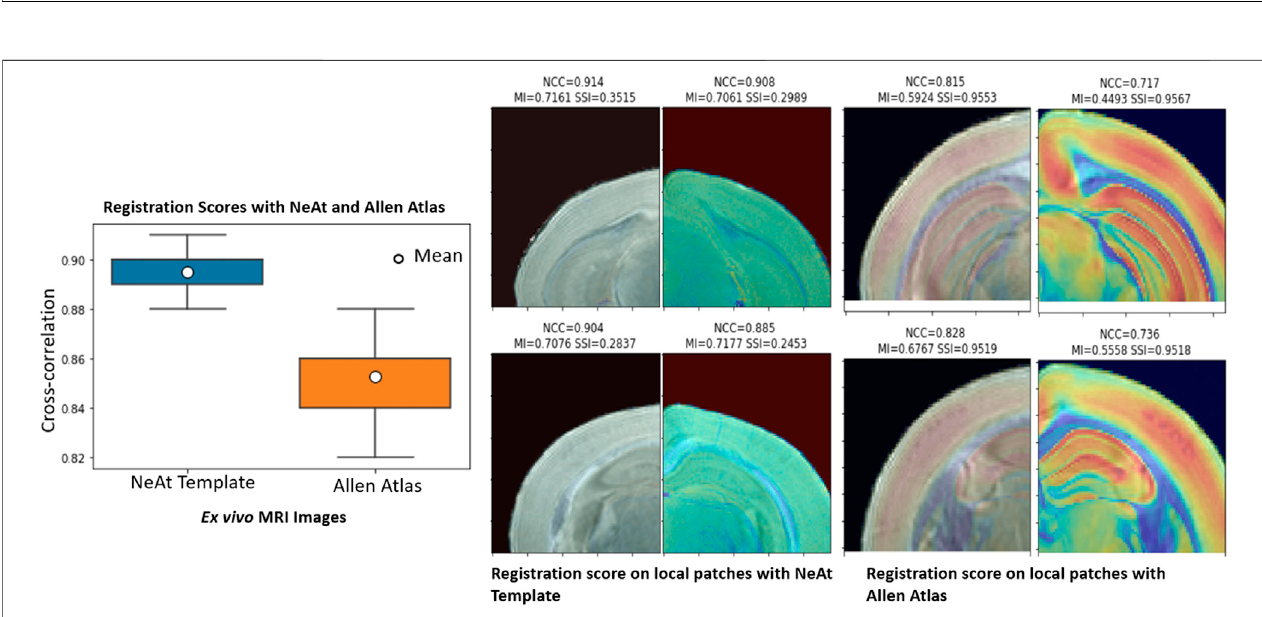
FIGURE 7 | Atlas/templates: Top row shows atlas/templates and bottom row shows their mask. The whole brain internal template (top-left) and NeAt template (secondfromtop-left)wereusedtoregister invivo and exvivo imagesrespectively.Thecerebelluminternaltemplatewasdevelopedtosegmentsub-cerebellarregionsof ex vivo images. Brain structures are delineated with separate color in the mask.